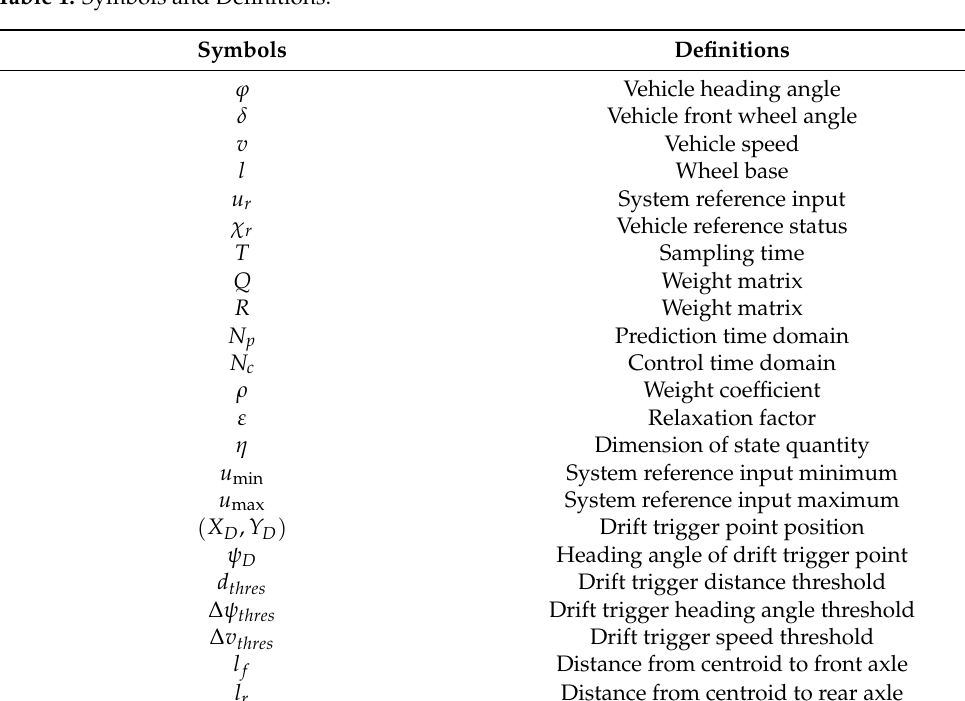
Figure 2. Kinematic model. Table 1. Symbols and